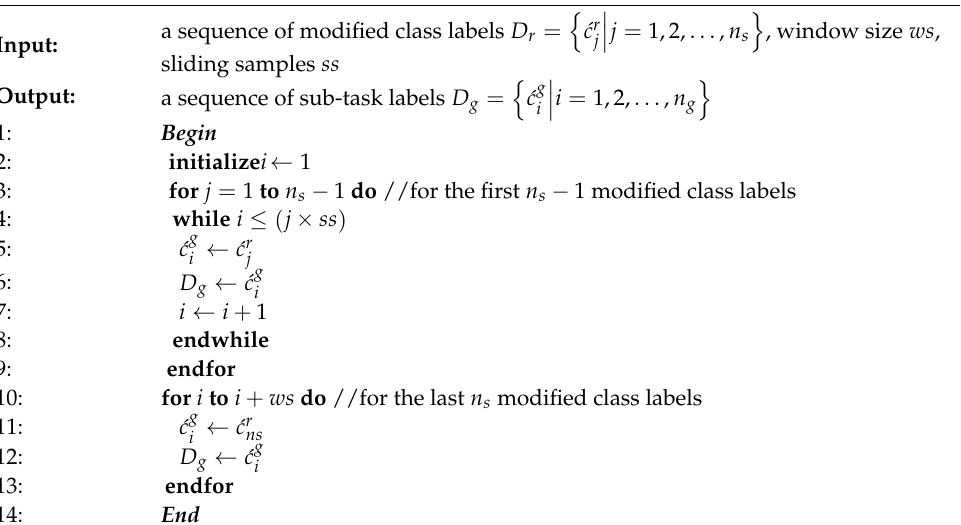
Algorithm 2: Sub-task Information